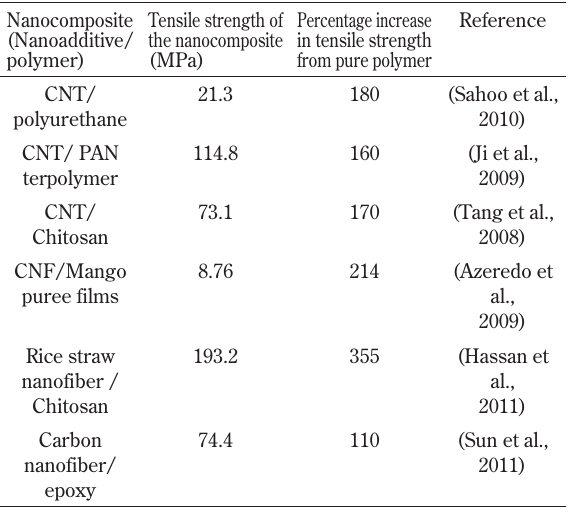
Table 3 Tensile strength properties of various nanocom- posites using nanofibres and nanotubes Nanocomposite (Nanoadditive/